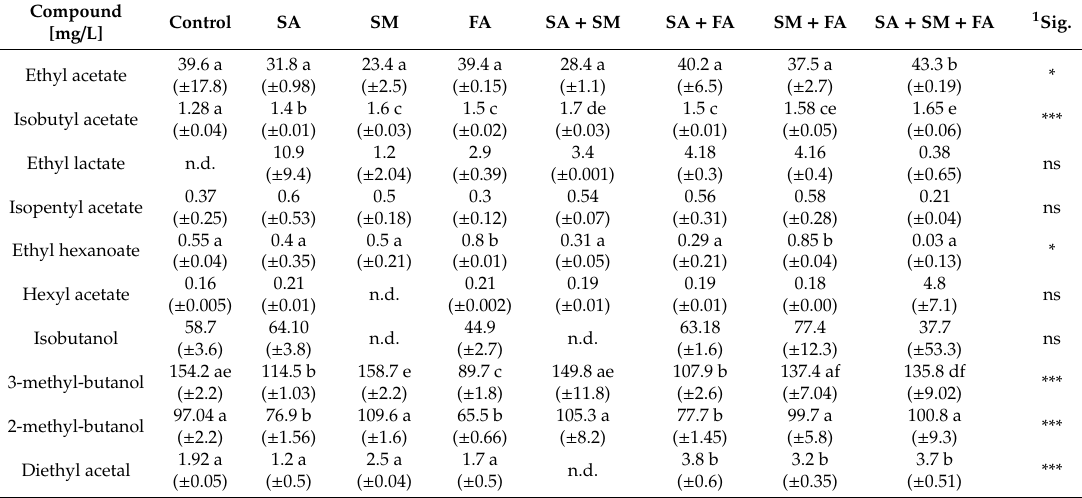
Table 12. Volatile compounds in ciders fermented by cider yeast (C), with the following additions: SA—ammonium sulfate, SM—magnesium sulfate, FA—ammonium